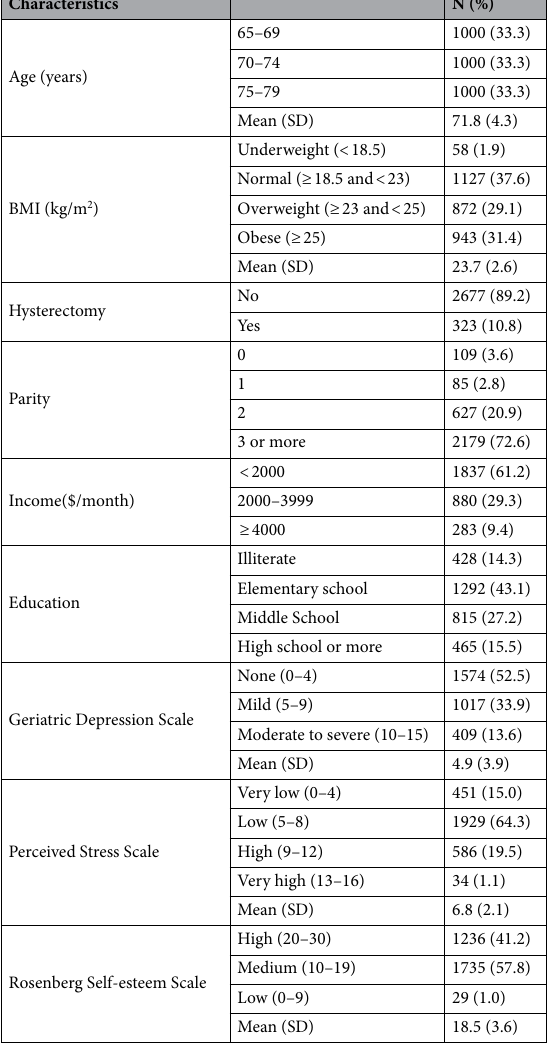
Table 1. Sociodemographic characteristics and mental health (n =